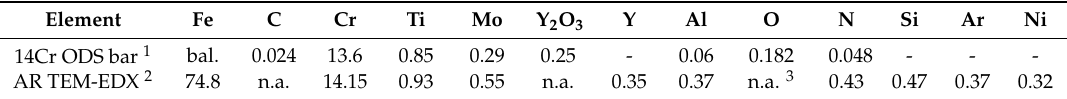
Table 1. Chemical composition of the 14Cr ODS steel in weight percent.